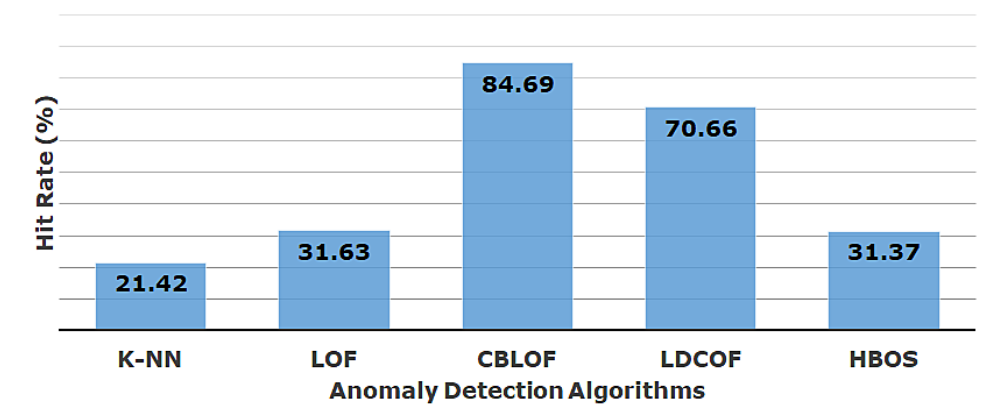
Figure 7. Overall performance